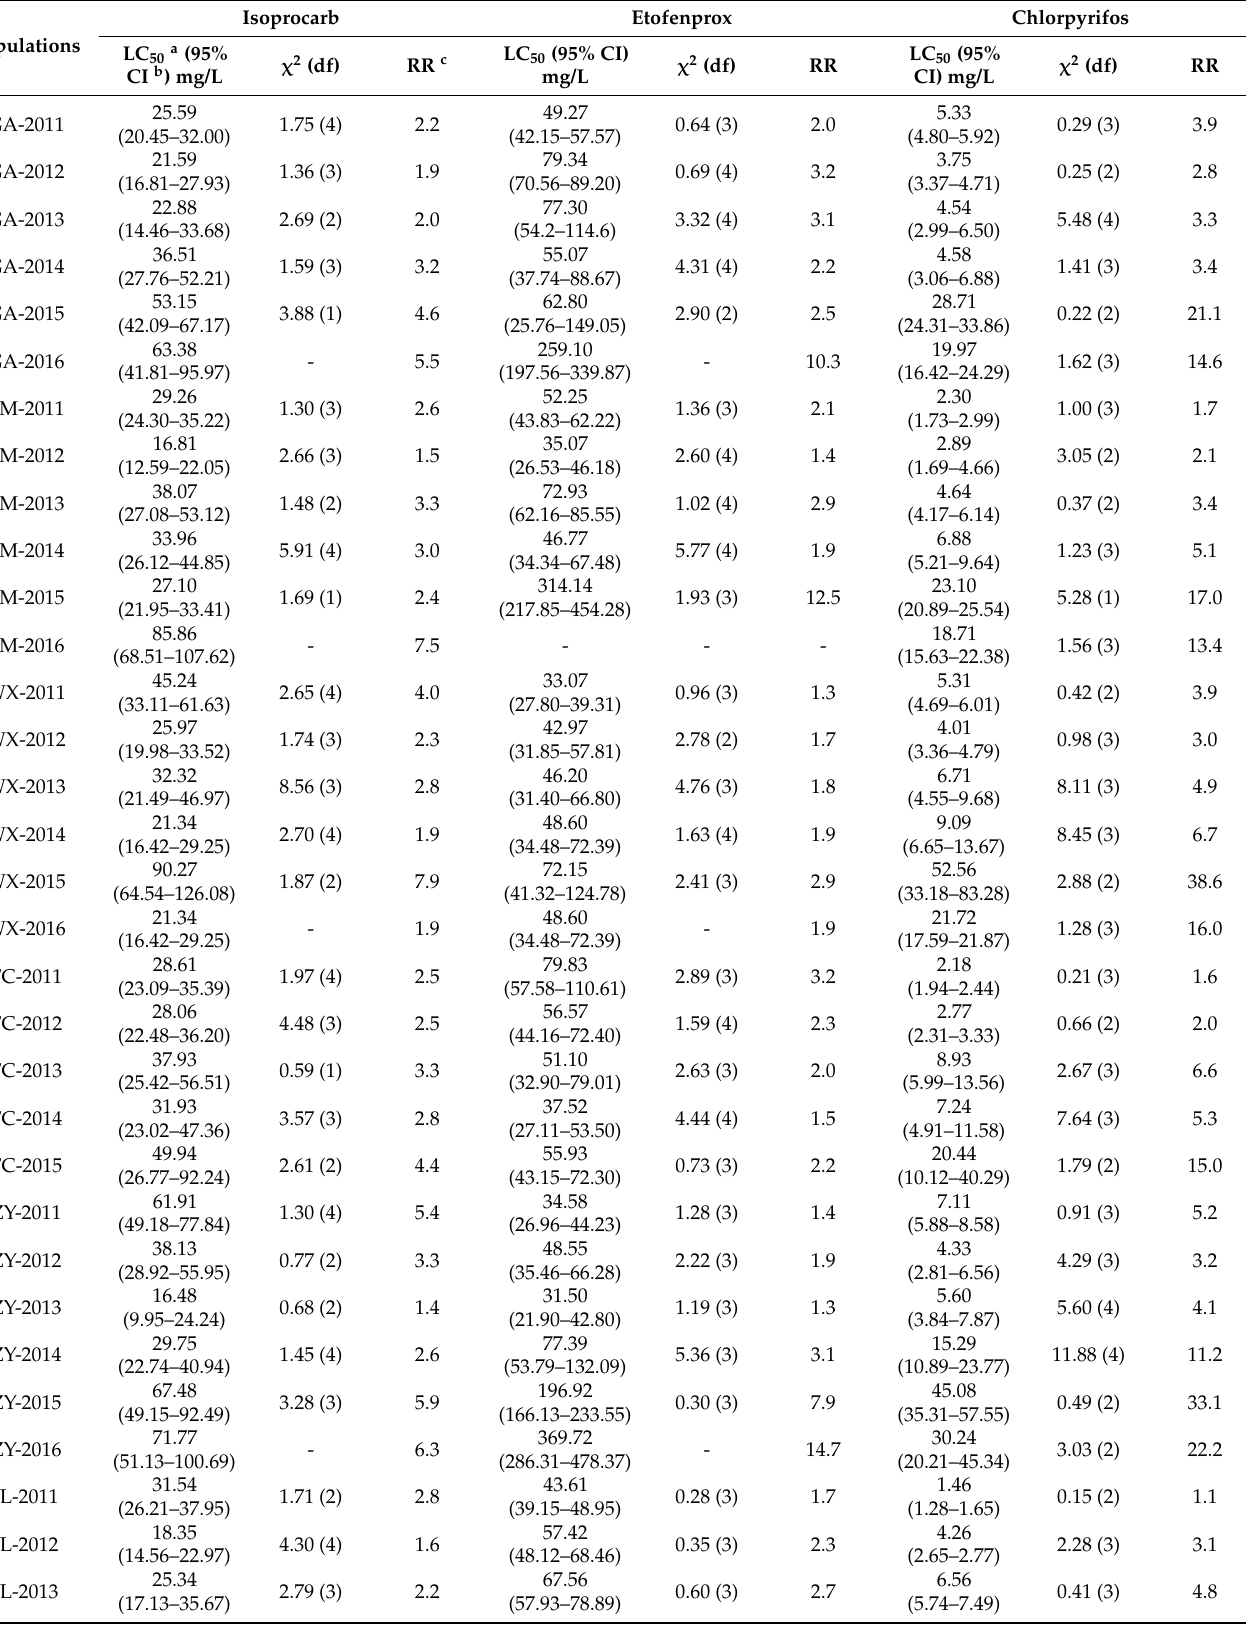
Table 4. The resistance to 3 groups of insecticides in S. furcifera field populations from 2011 to